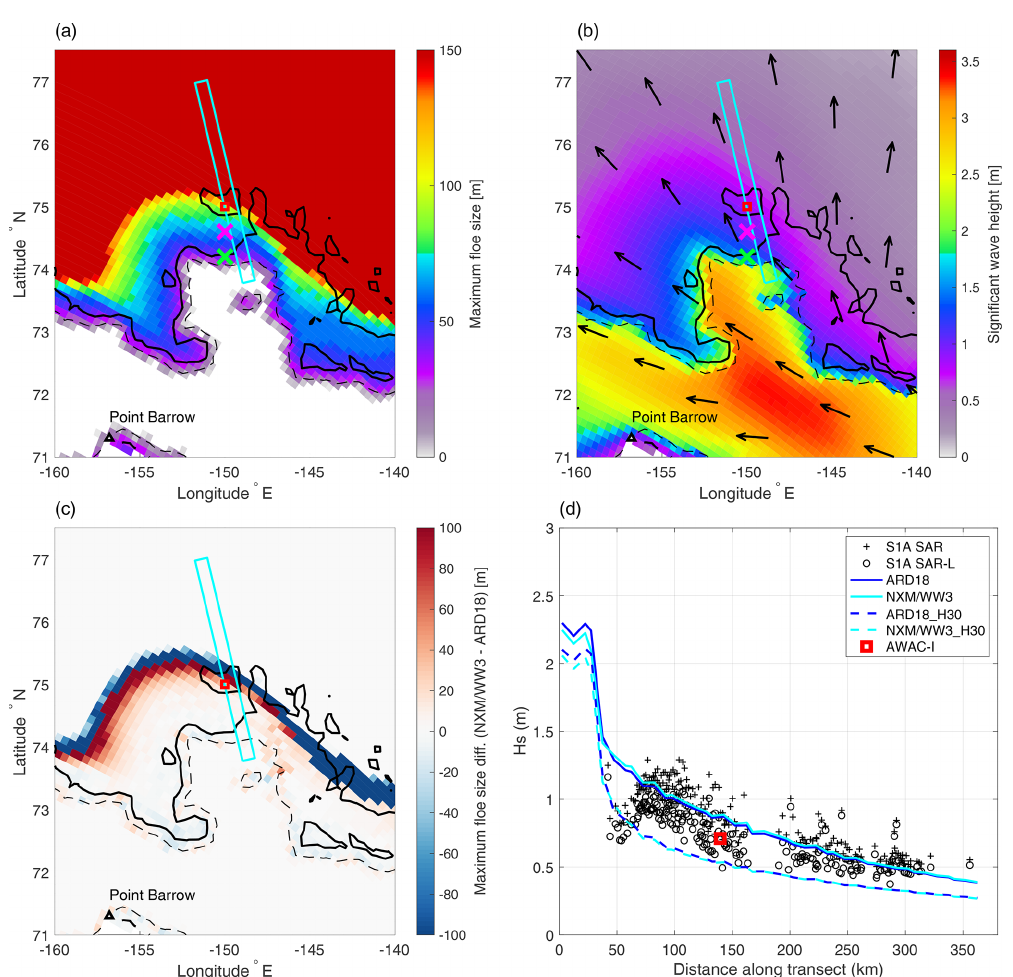
Figure 3. Spatial distributions of maximum floe size (a) and significant wave height (b) in the Beaufort Sea taken from the NXM/WW3 simulation on 12 October at 17:00:00GMT. Black arrows indicate the wave mean direction. The difference of the maximum floe size distribution with the ARD18 simulation is shown in panel (c) . Evolution of the significant wave height for different simulations along the transect depicted in cyan in panels (a) – (c) is presented in panel (d) , along with significant wave height estimated from Sentinel-1a SAR images (see Stopa et al., 2018a; Ardhuin et al., 2018, for details) and measured by an AWAC buoy. The AWAC position is depicted by a red square in panels (a) – (c) . The green and magenta crosses indicate the position at which the FSDs are shown in Fig. 4. Solid and dashed black lines represent contours of sea ice concentration equal to 0.8 and 0.15, respectively. Point Barrow is indicated by a black